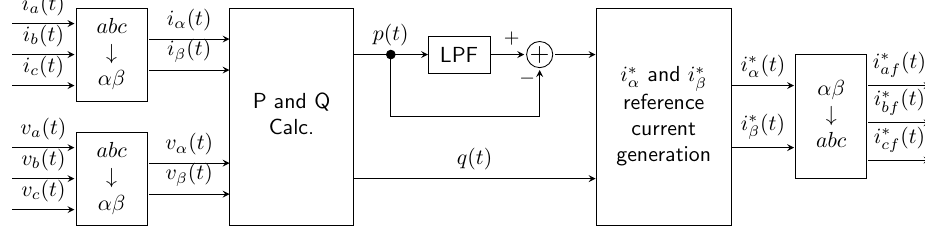
Figure 2. Block diagram of instantaneous reactive p-q theory.